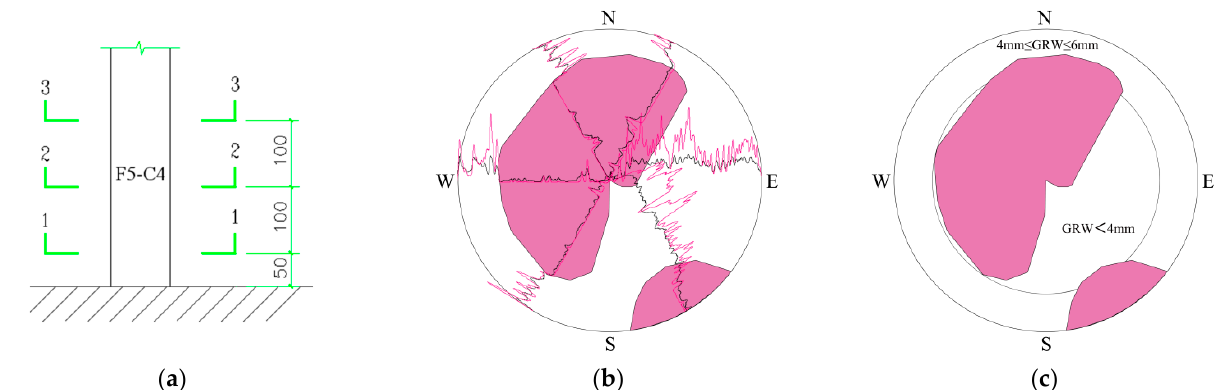
Figure 23. Micro-drilling test of F5-C4; ( a ) testing sections; ( b ) decay area determined by micro-drilling maps; ( c ) different GRW areas.